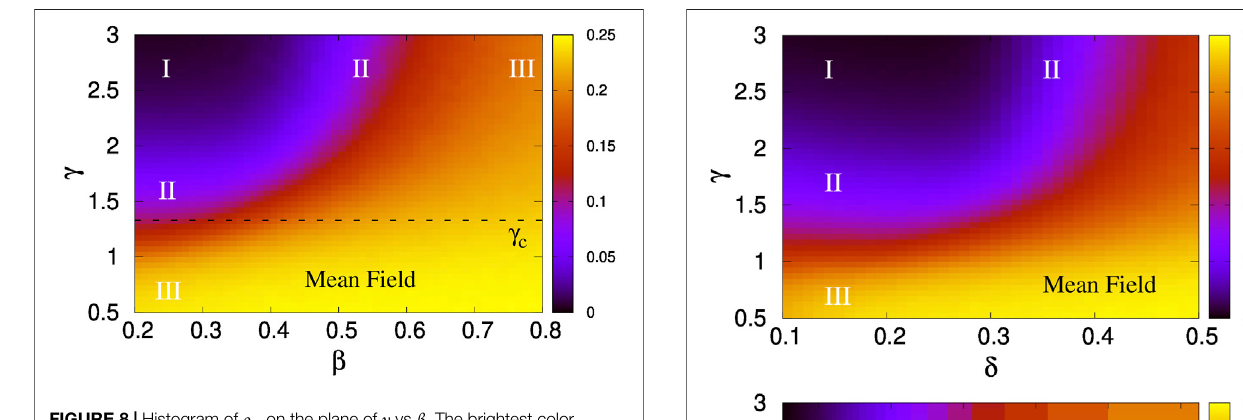
FIGURE 8 | Histogram of ρ m on the plane of c vs β . The brightest color correspondsto ρ m ≈ 0.25whilethedarkestcolorstandsfor ρ m ≈ 1/ L .Atlow β , as c increases, we go from region 3 (percolation) to 2 (avalanche) to 1 (nucleation). Same transition is observed when β decreases at high c .